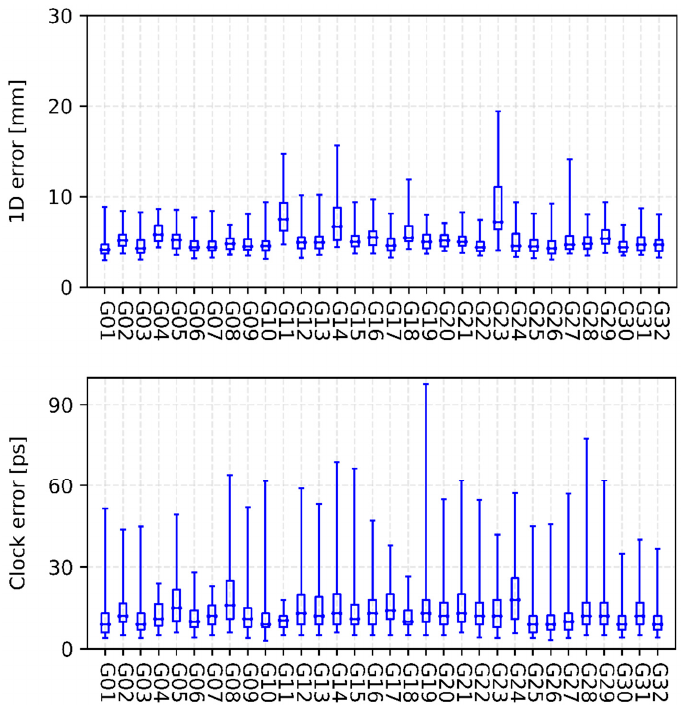
Figure 3. Internal precision of iGMAS final combined GPS orbit ( top panel ) and clock ( bottom panel ).